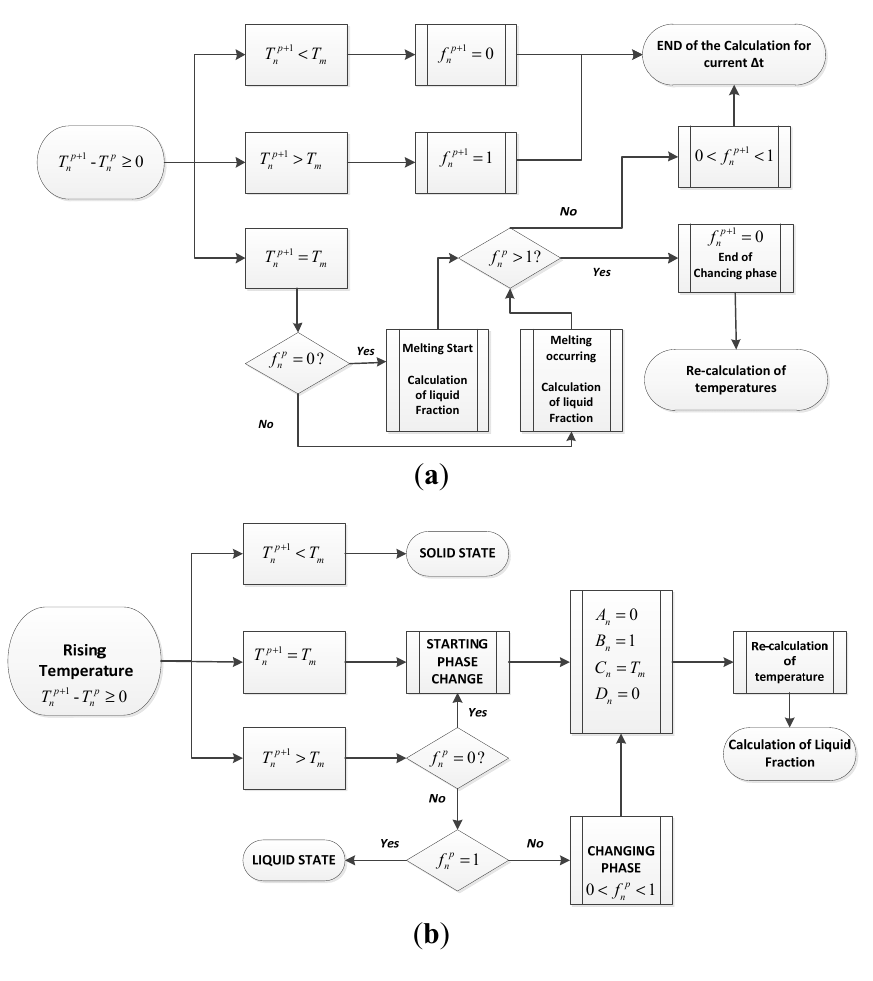
Figure 4. Flow diagram of ( a ) temperature calculation and ( b ) liquid fraction calculation (rising